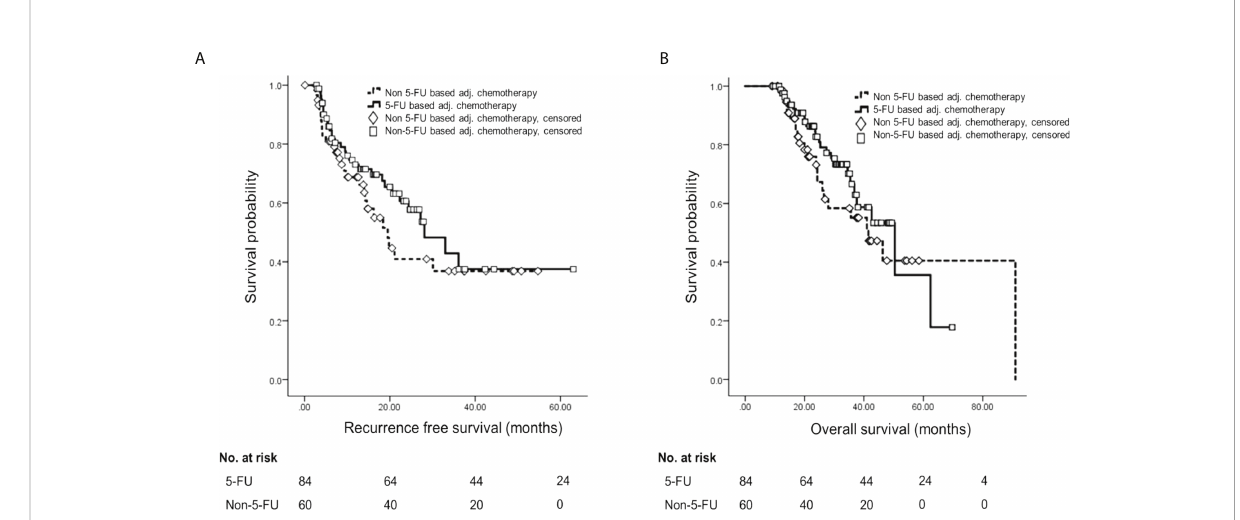
FIGURE 2 Survival analysis by Kaplan – Meier method and multivariable Cox proportional hazards analysis according to adjuvant treatment. (A) Kaplan – Meier curve of RFS according to adjuvant chemotherapy regimen. (B) Kaplan – Meier curve of OS according to adjuvant chemotherapy regimen.